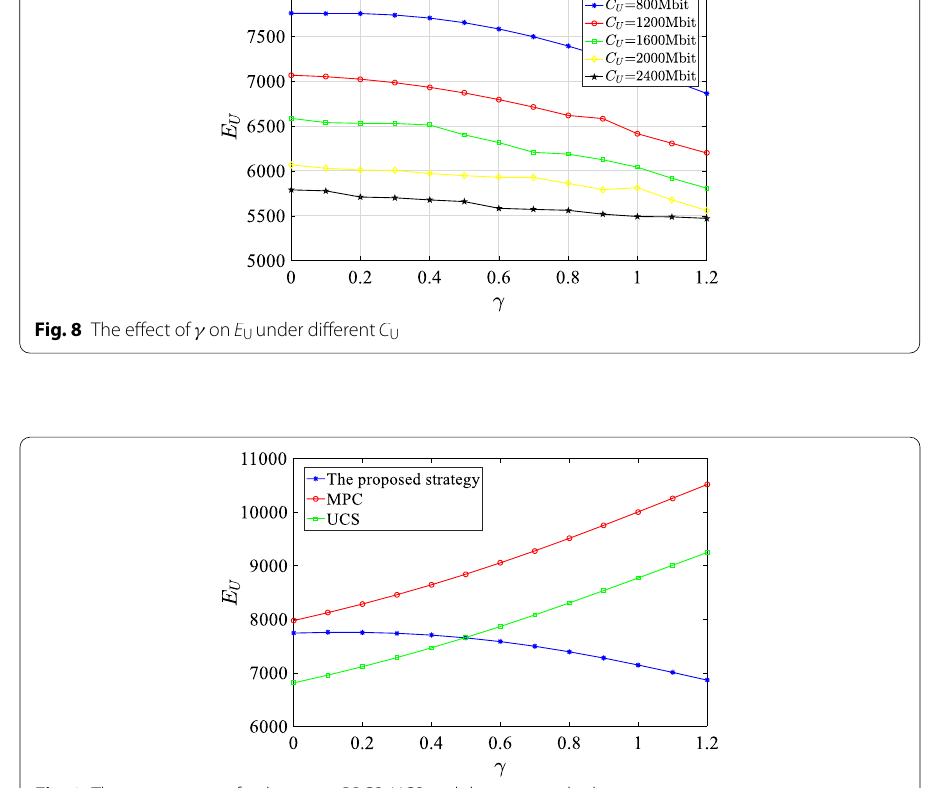
Fig. 9 The comparison of E U between PBCS, UCS and the proposed